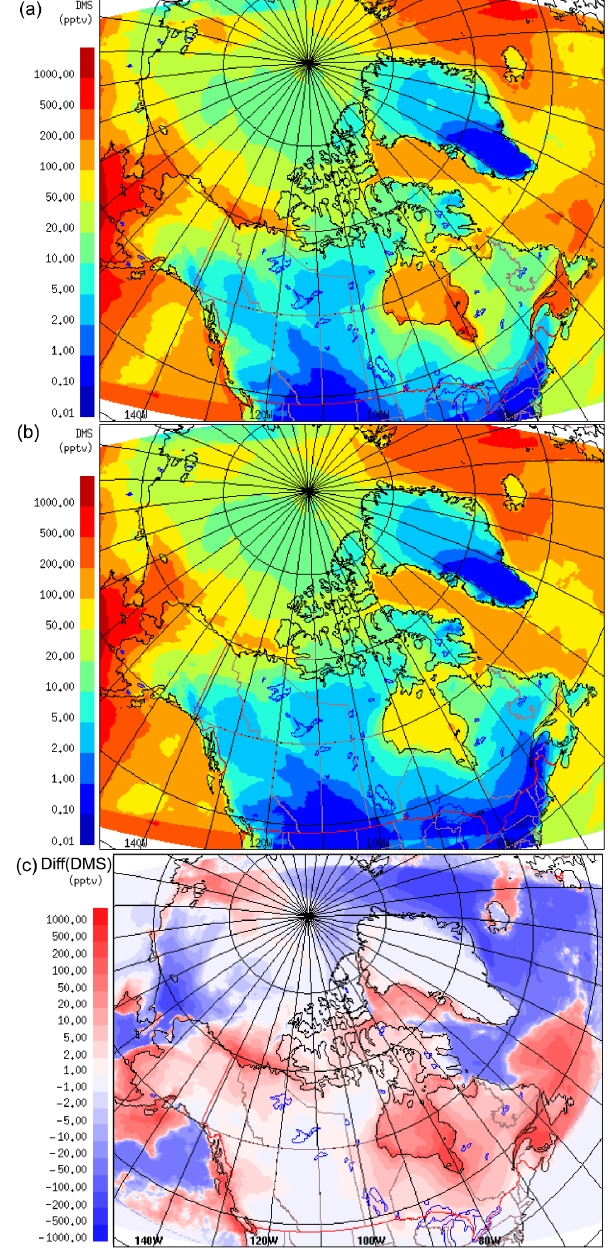
Figure 3. DMS(g) mean mixing ratios for July 2014, at 20m, the lowest model level, using SAT (a) and CLIM11 (b) . Panel (c) shows the difference between SAT and CLIM11